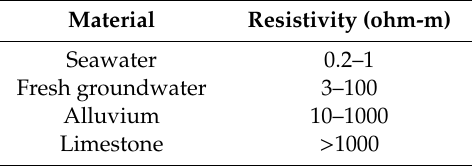
Table 3. Electrical resistivity of some earth materials proposed by